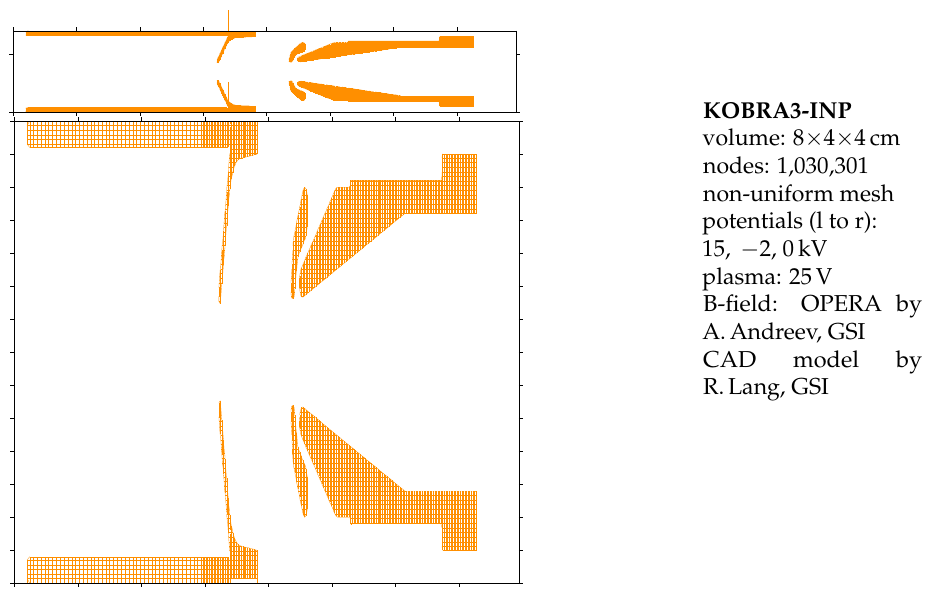
Figure 4. CAPRICE computer model. Top: correct aspect ratio. Bottom: enlarged scale.